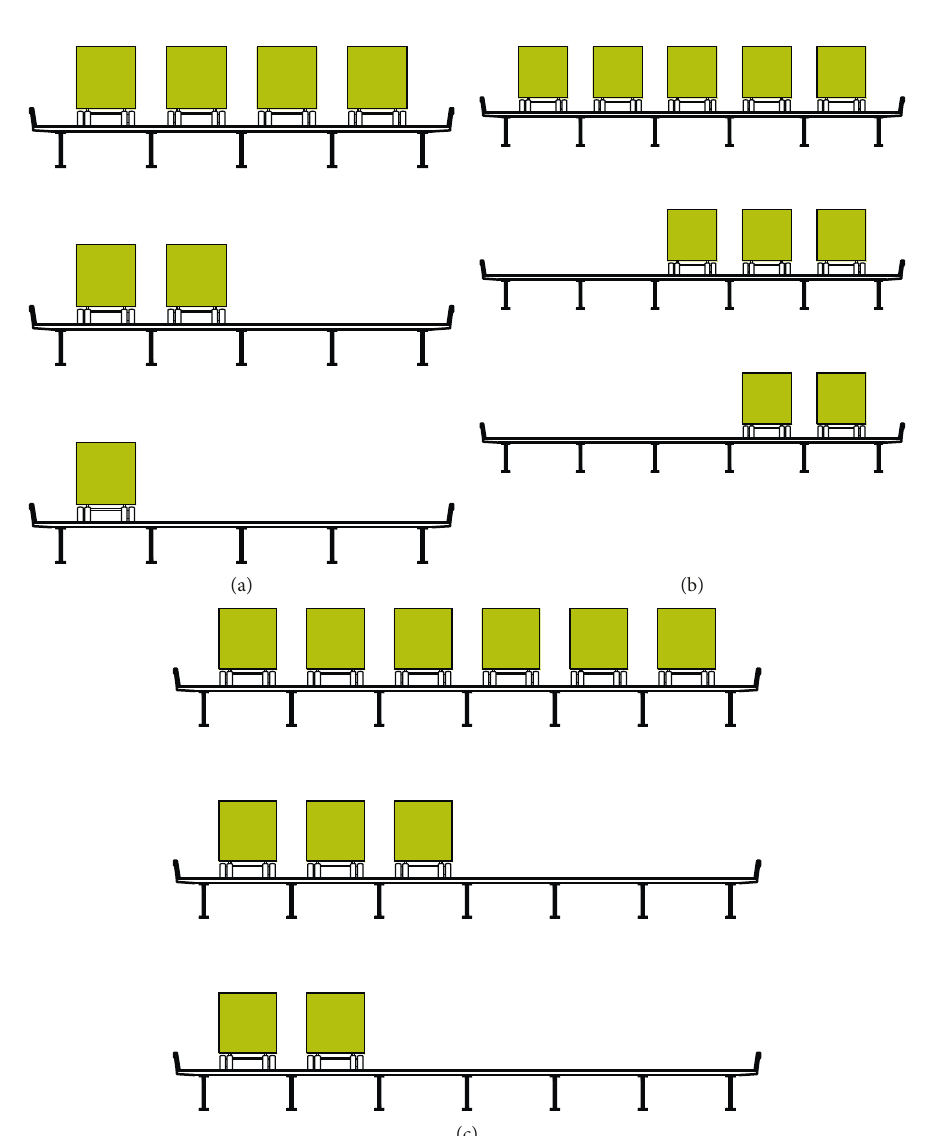
Figure 4: Cross-sectional view of truck arrangement on loaded bridges: (a) four lanes; (b) five lanes; (c) six